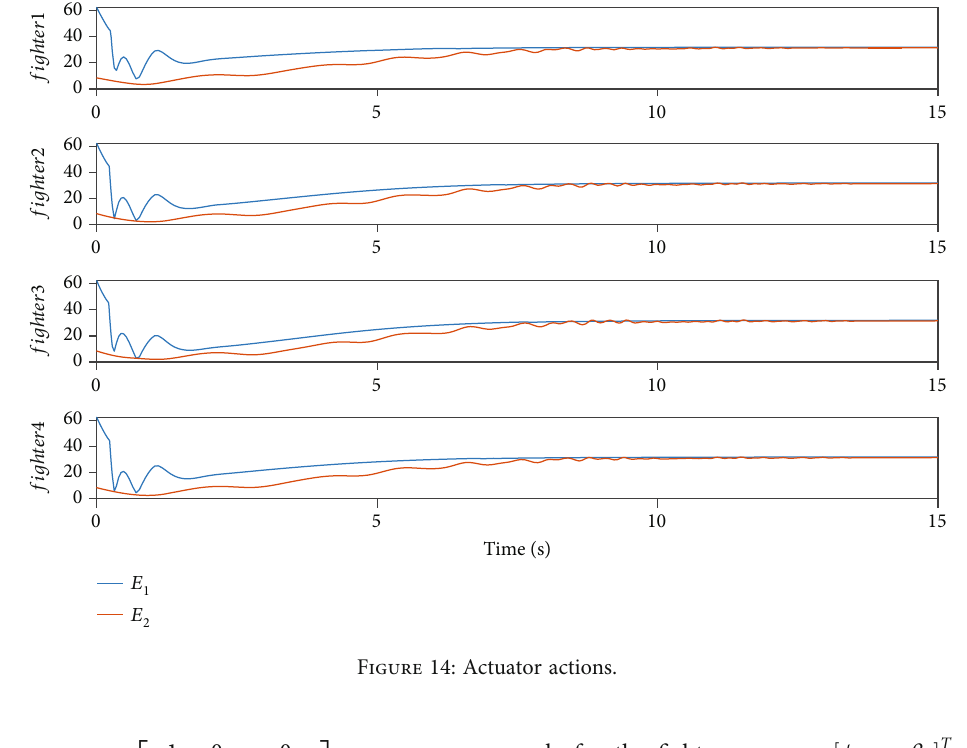
Figure 14: Actuator